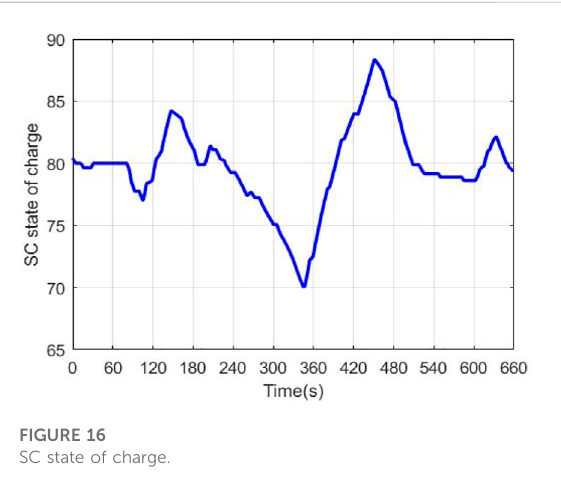
FIGURE 16 SC state of